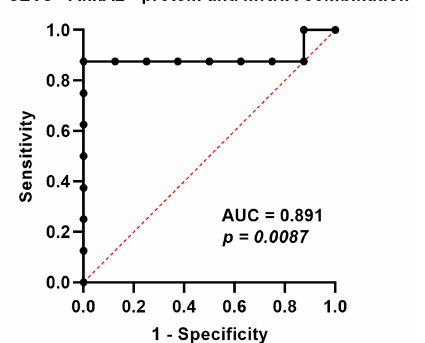
Figure 5. AnxA2 protein and mRNA present in sEVs as a combined biomarker for the prediction of effective neoadjuvant chemotherapy. ROC curve for serum sEV-AnxA2 protein and mRNA as a combined biomarker for the prediction of responsiveness or non-responsiveness to neoadjuvant chemotherapy in the TNBC patients with stage 3 and above (n = 8).